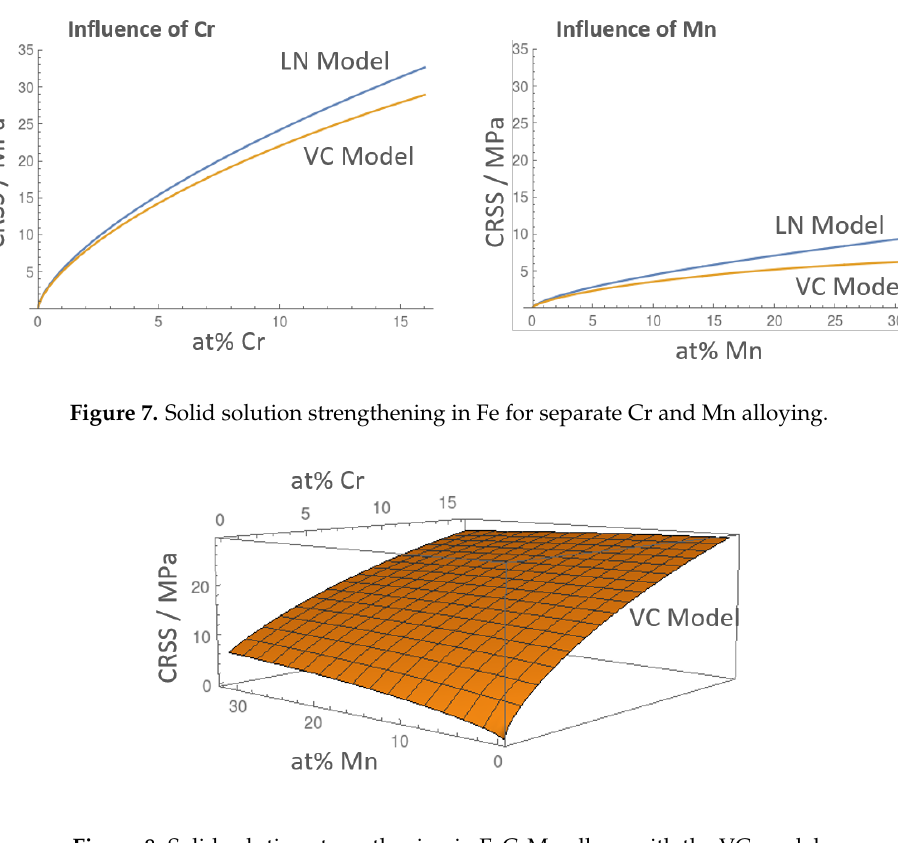
Figure 8. Solid solution strengthening in FeCrMn alloys with the VC